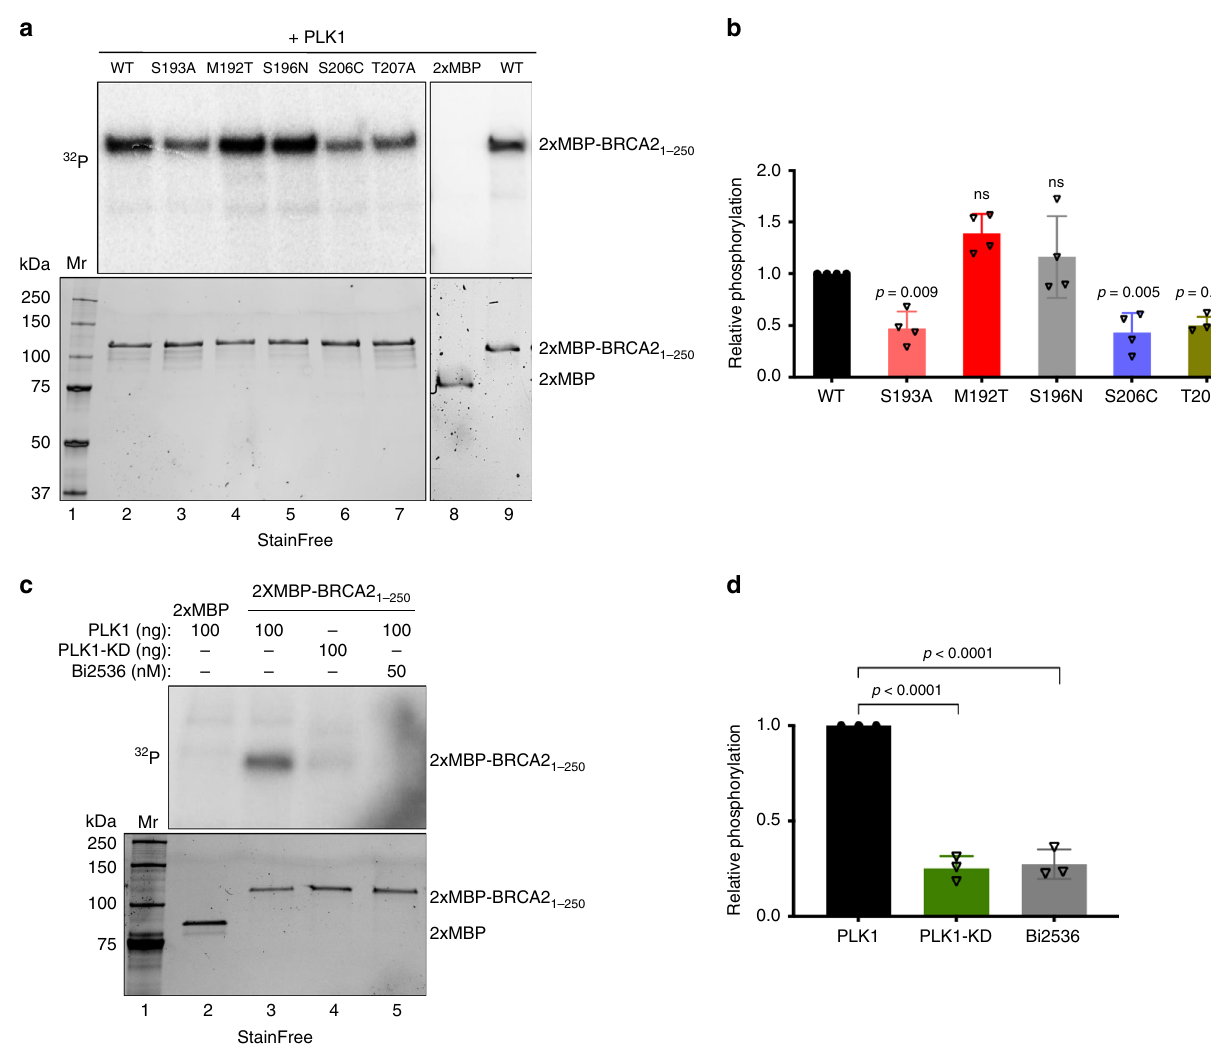
Fig. 1 BRCA2 VUS alter PLK1 phosphorylation of BRCA2 1-250 . a PLK1 in vitro kinase assay with BRCA2 1 – 250 . Top: The polypeptides encompassing 2×- MBP-BRCA2 1 – 250 WT or S193A, M192T, S196N, S206C, T207A mutations or the 2XMBP tag were incubated with recombinant PLK1 in the presence of γ 32 P-ATP. The samples were resolved on 7.5% SDS-PAGE and the 32 P-labeled products were detected by autoradiography. Bottom: 7.5%